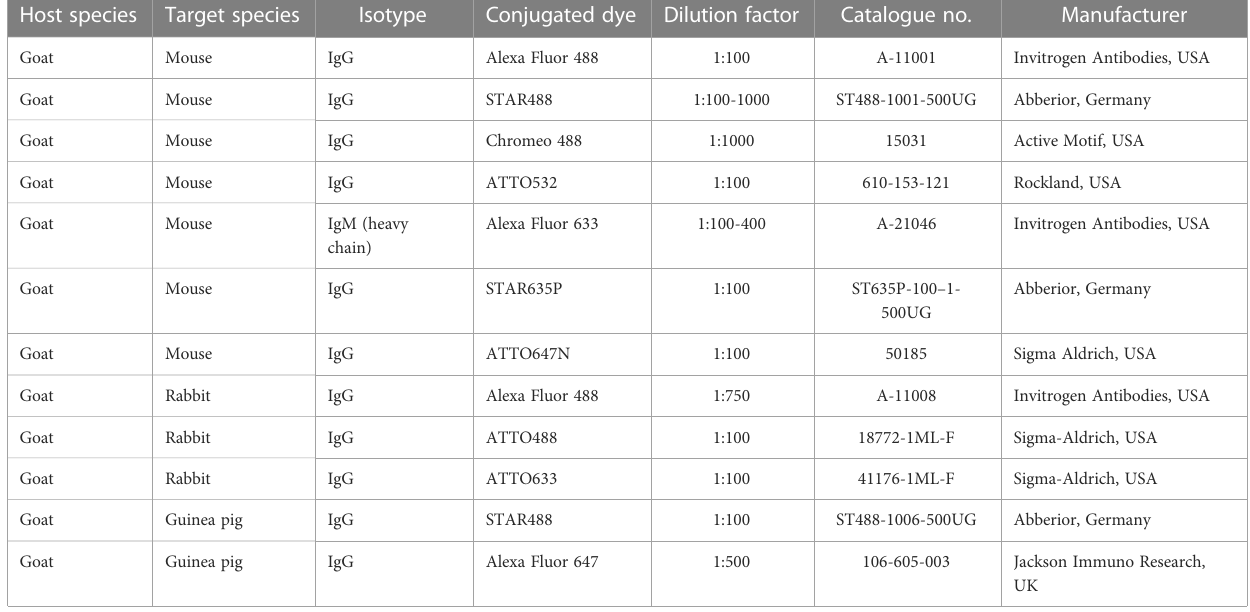
TABLE 2 The following species-speci fi c secondary antibodies were